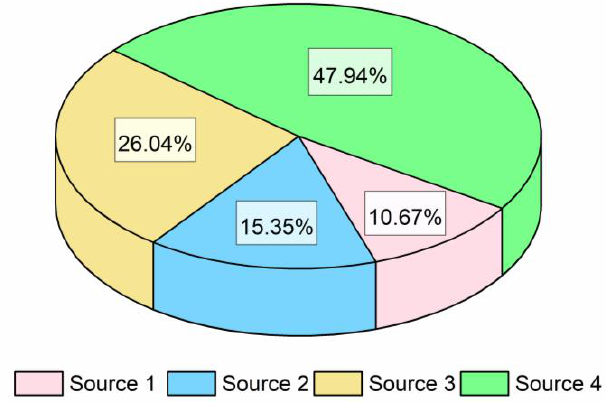
Figure 5. The proportion of different pollution sources.